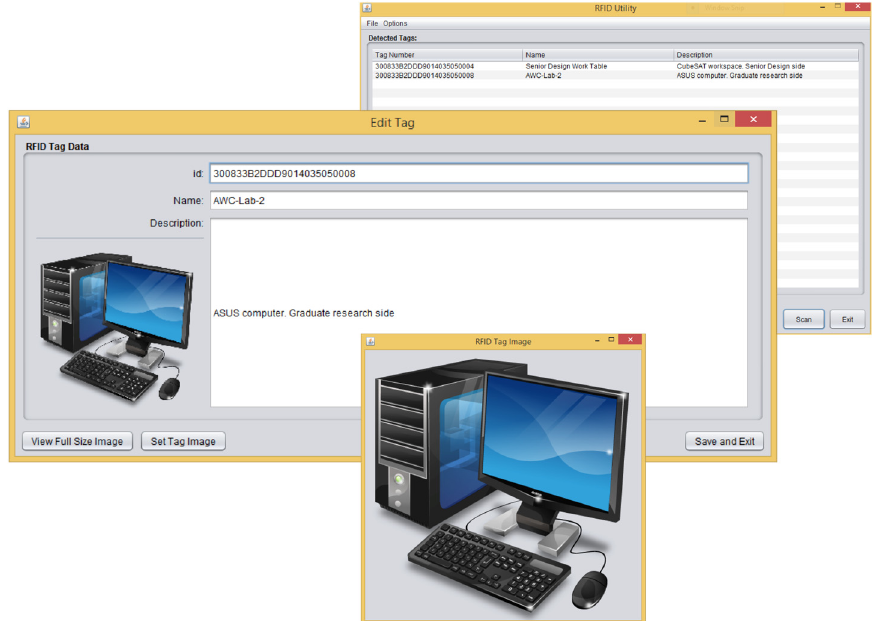
Figure 4. Examples of windows in the software interface. The windows visible from back to front are: the main tag read window for all tags, the detailed view of all database information pertaining to a single tag, and the full-sized picture associated with the tag.